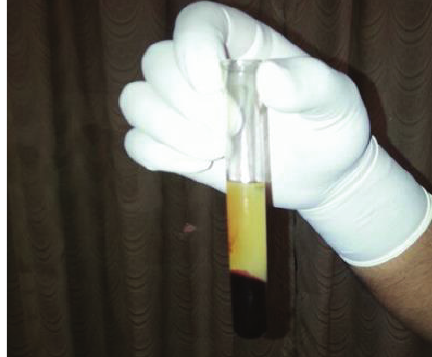
Figure 3: Preparation of platelet rich fibrin.